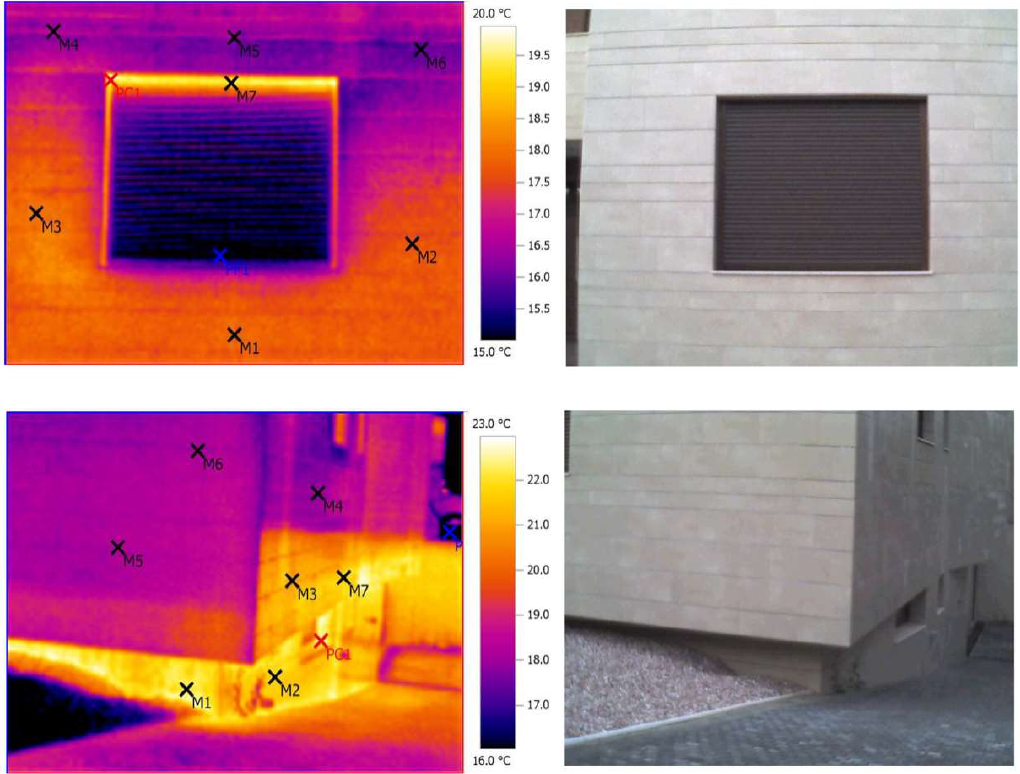
Figure 18. Casa Zaranda thermographies.